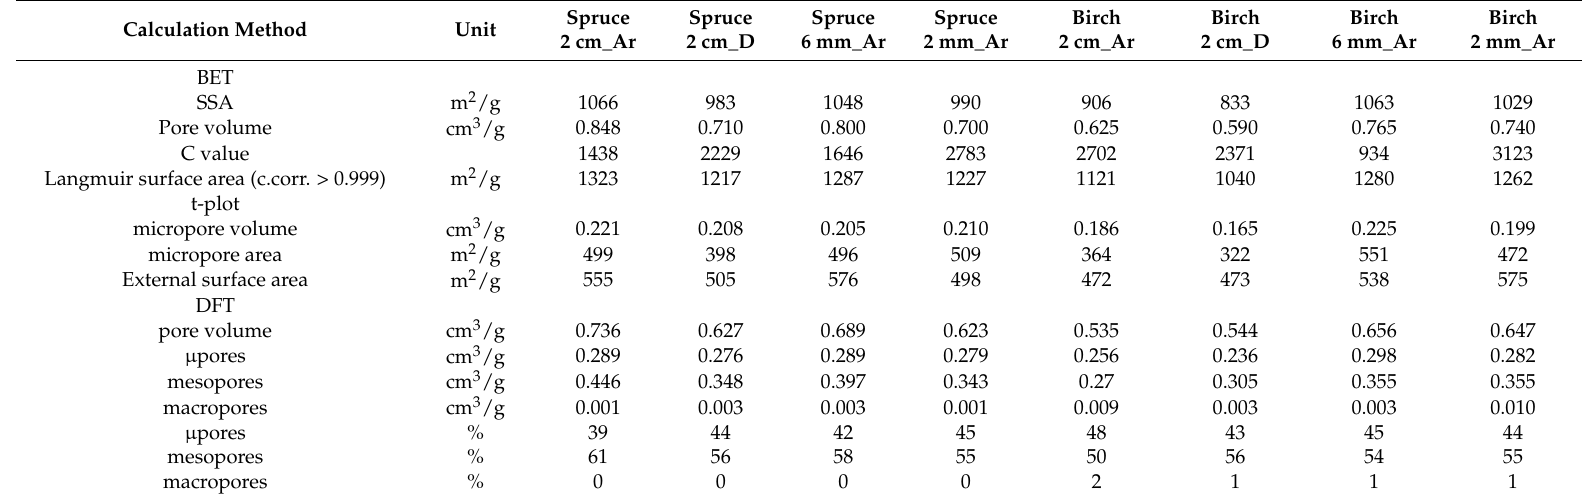
Table 3. Specific surface areas (SSA) and pore size distributions of the different activated carbons (ACs). BET: Brunauer–Emmett–Teller; DFT: Density functional